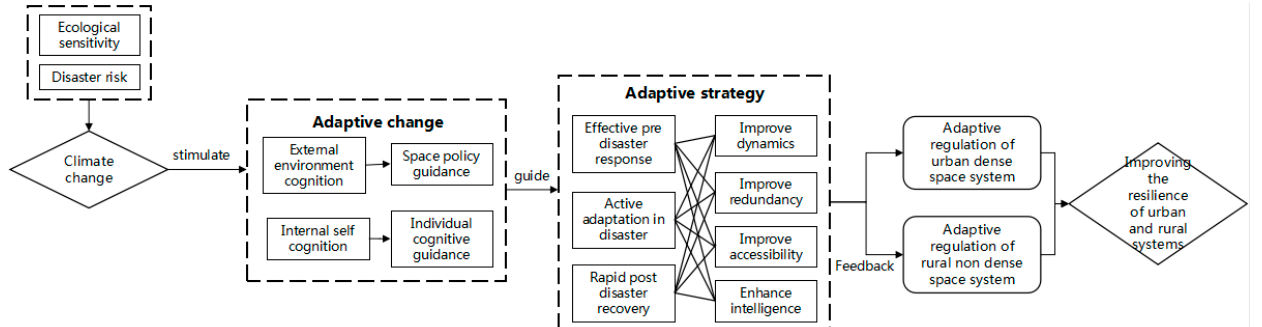
Figure 14. The adaptive planning strategy (Source: self-drawn by the author).